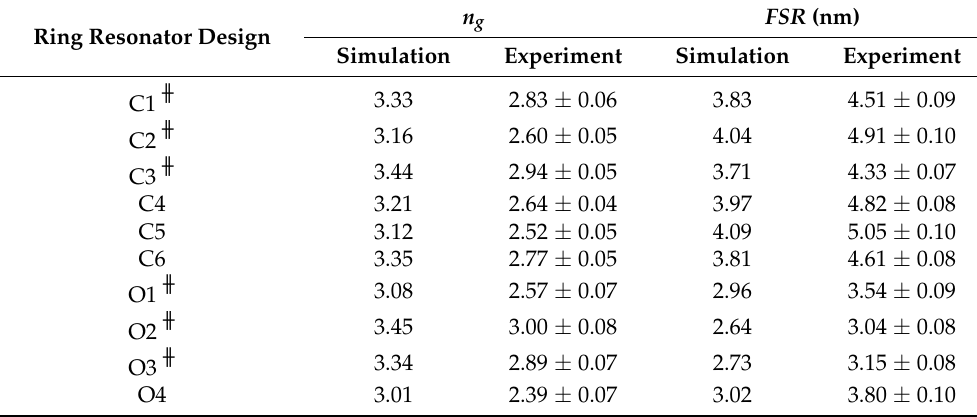
Table 2. Group index, n g , and free spectral range ( FSR ) for SWG ring resonators obtained from 3D- FDTD band structure simulations with as-designed structures and experiments. For each resonator, n g and FSR were calculated based on all resonances measured over a wavelength range of 1530–1560 nm for the C-band devices and 1270–1310 nm for the O-band devices. The reported values are the mean ± one standard deviation for these measurements from five replicate chips.